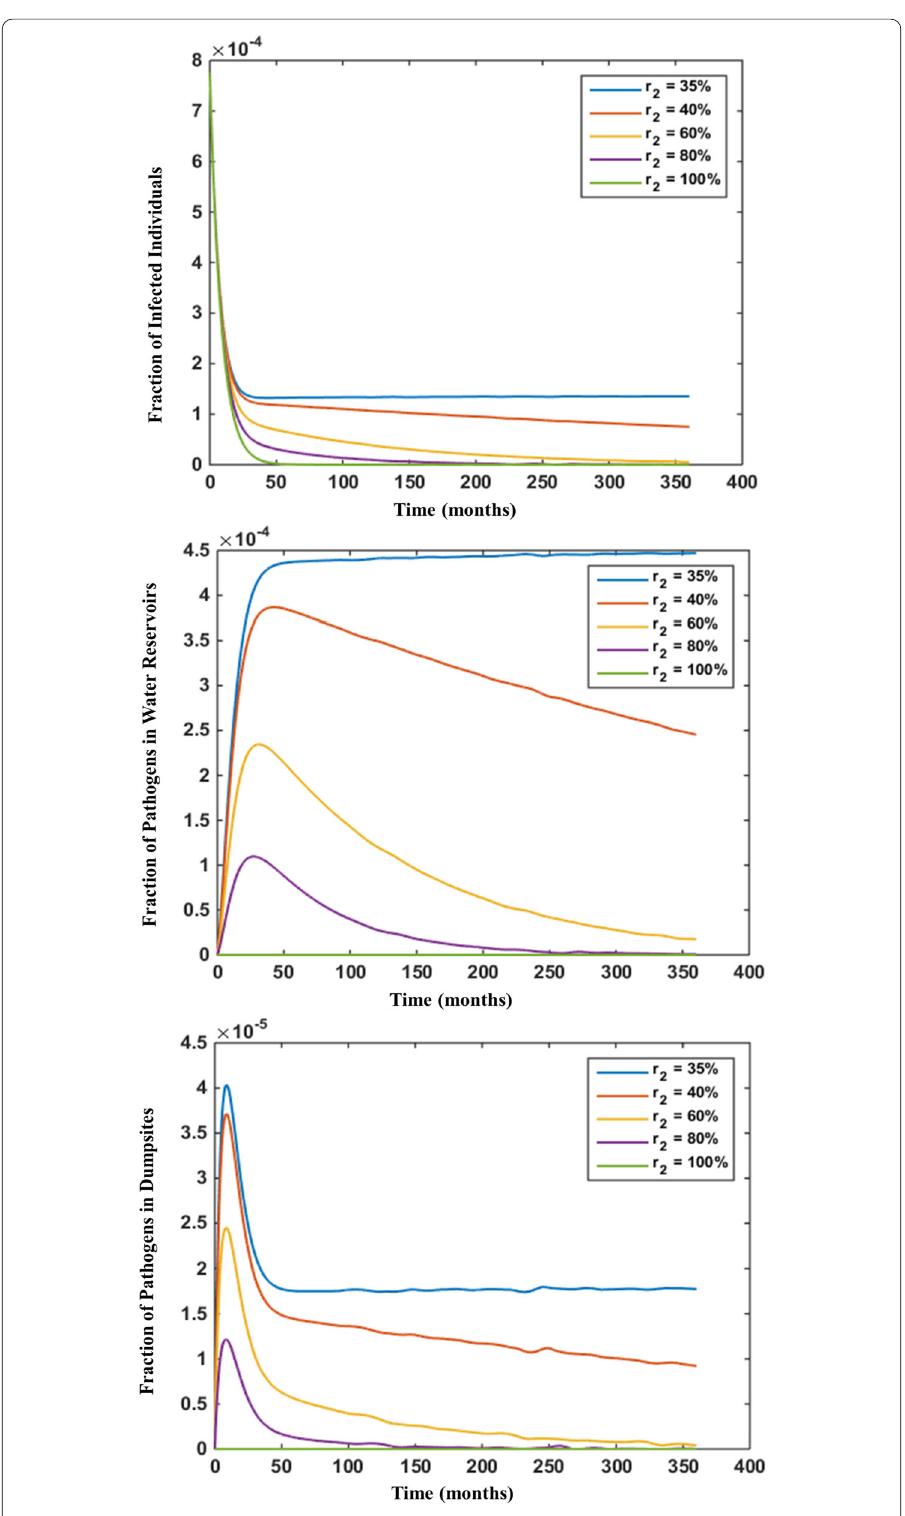
Figure 5 Dynamic behavior of the fraction of infected individuals (top), fraction of pathogens in water reservoirs (middle), and fraction of pathogens in dumpsites (bottom), with r 1 = 65%, r 3 = 10%, and varying r 2 from 35%, 40%, 60%, 80%, and